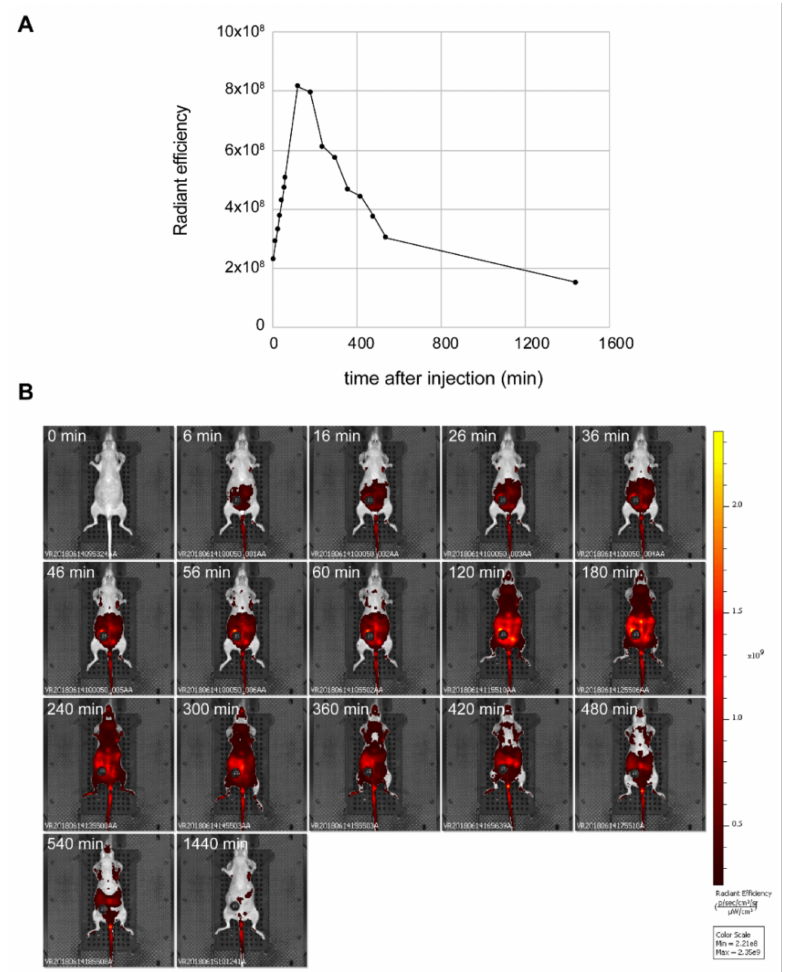
Figure 2. NS1 monitoring in vivo by an IVIS in vivo imaging system after a single IP injection in nude mice (NS1 concentration was 40 mg/kg in PBS). ( A , B ) Time course of NS1 fluorescence was monitored by in vivo imaging (the excitation was at 465 nm and the emission at 620 nm) by IVIS for 24